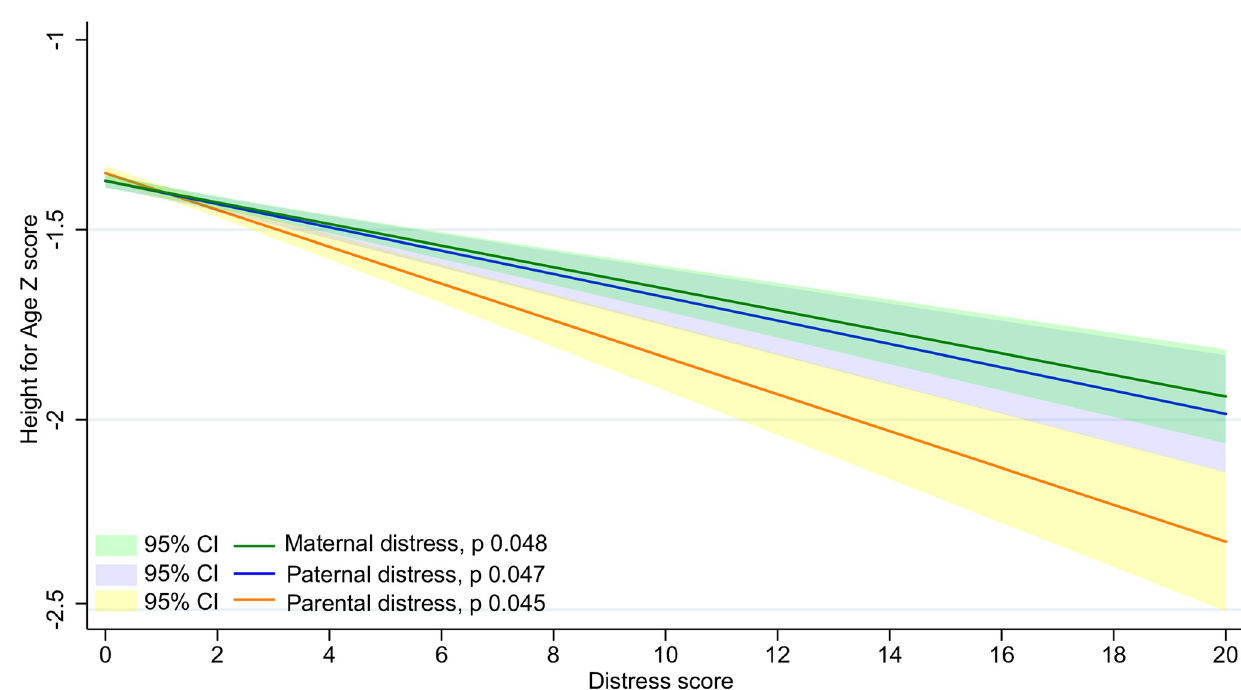
Fig 3. The association between distress of parents and child height-for-age z score. Distress is SRQ20 score, p values indicate significance of the regression coefficient for Height-for-Age Z score versus Distress score, shaded regions are the 98% CI for the fitted line.